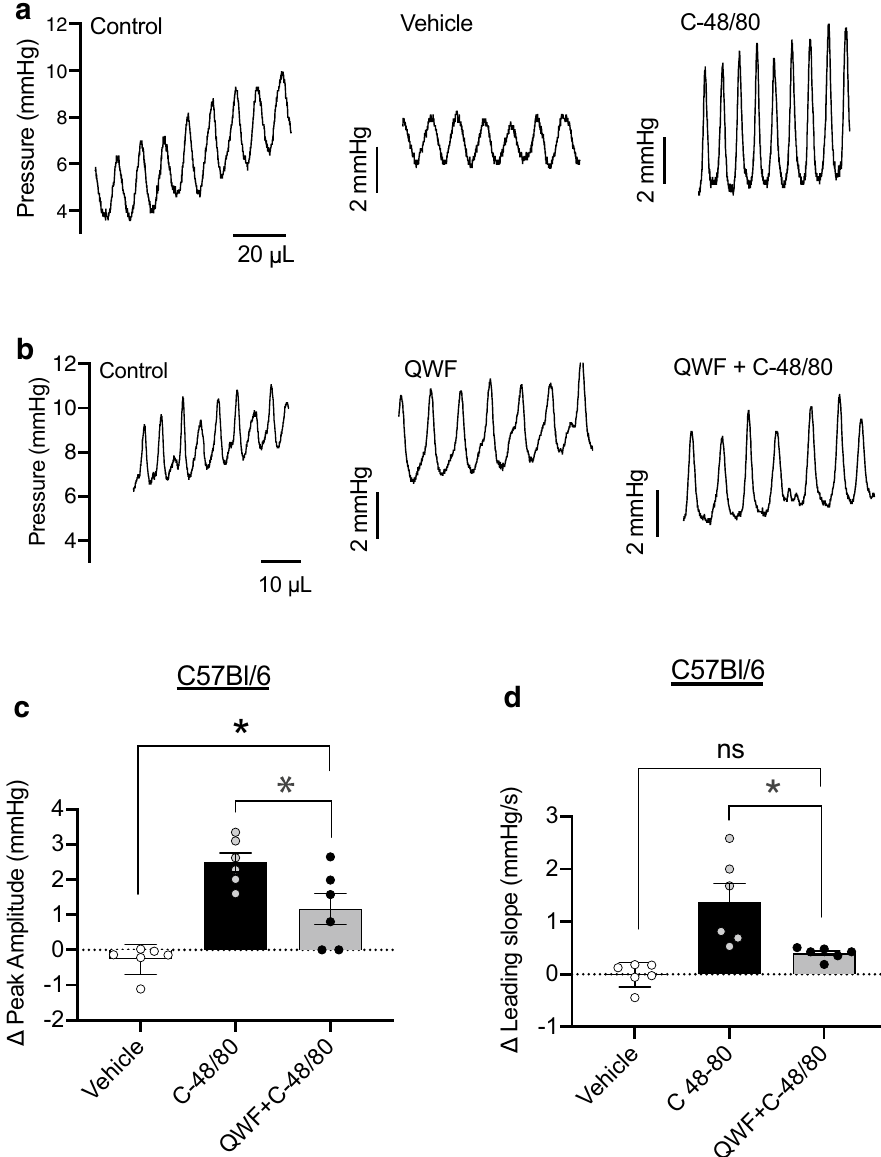
Figure 6. Compound 48/80 increases the amplitude and leading slope of transient contractions through Mrgprb2 activation. Representative trace of transient pressure events during ex vivo filling of a C57Bl/6 mouse bladder during control fill, fill in presence of vehicle ( a ) 10 µM QWF ( b ) (N = 6), and after exposure to 10 µg/mL Compound 48/80 (N = 6). ( c , d ) the increase in both leading slope ( P = 0.014, N = 6, C-48/80 vs. QWF + C-48/80) and peak amplitude ( P = 0.024, N = 6, C-48/80 vs. QWF + C-48/80) by Compound 48/80 was blocked by QWF. There was an increase in peak amplitude due to Compound 48/80 even in the